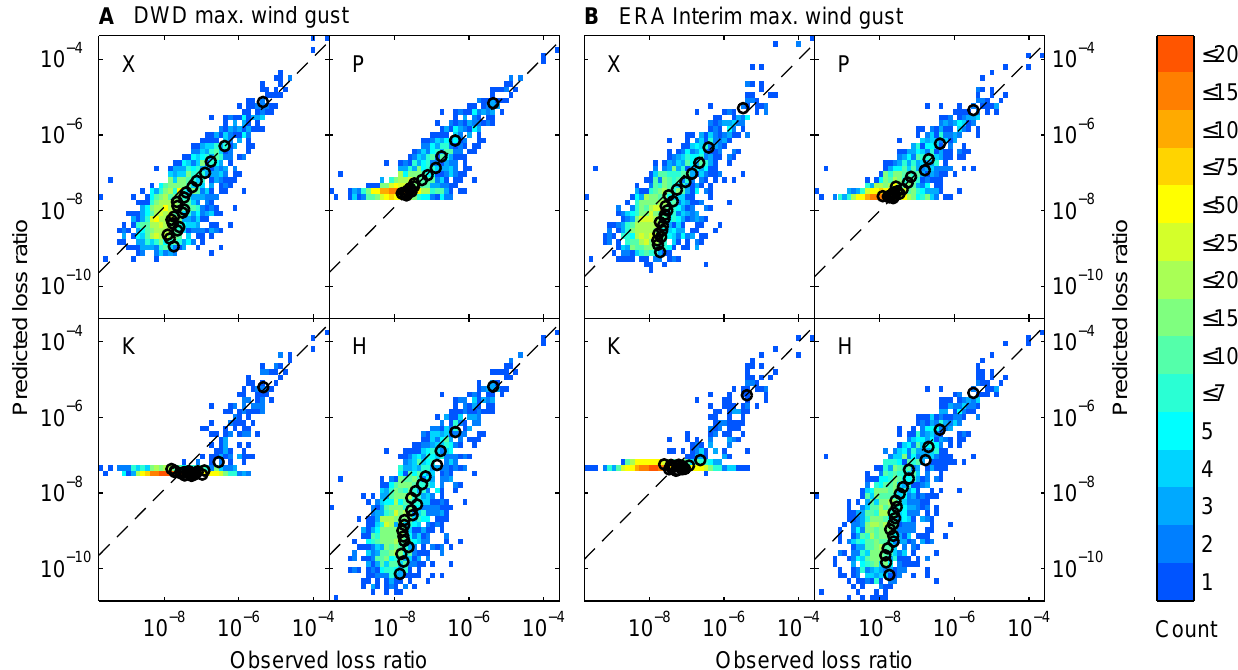
Figure 4. On country level, the predicted daily loss ratio (expected value) for each model is plotted versus observed losses using a double- logarithmic scale. (a) shows results based on DWD wind-gust data, ERA-Interim wind-gust data are used in (b) . The colours indicate the 2-D histogram count. The black circles represent (linear) averages of 100 losses each, binned by descending order of predicted loss. Black dashed lines have unity slope and indicate equality of observation and